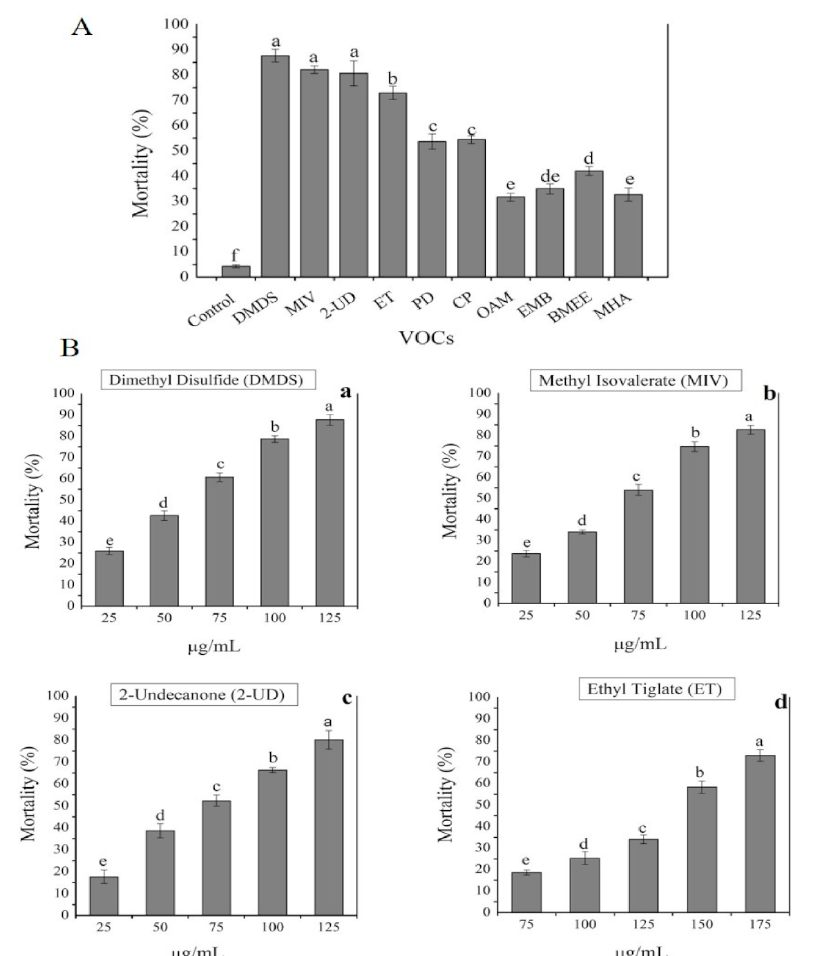
Figure 4. Nematicidal effect of pure VOCs with different concentrations against M. incognita . ( A ) The mortality rate of each pure VOC compared with control. ( B ) The killing effect of four strong nematici- dal VOCs ( a – d ) with different concentrations. The error bars represent the mean standard deviation of each treatment repeated three times with three replicates. The small letters above the columns indicate significant difference. The significance differences among treatments were calculated by Tukey’s HSD test at p ≤